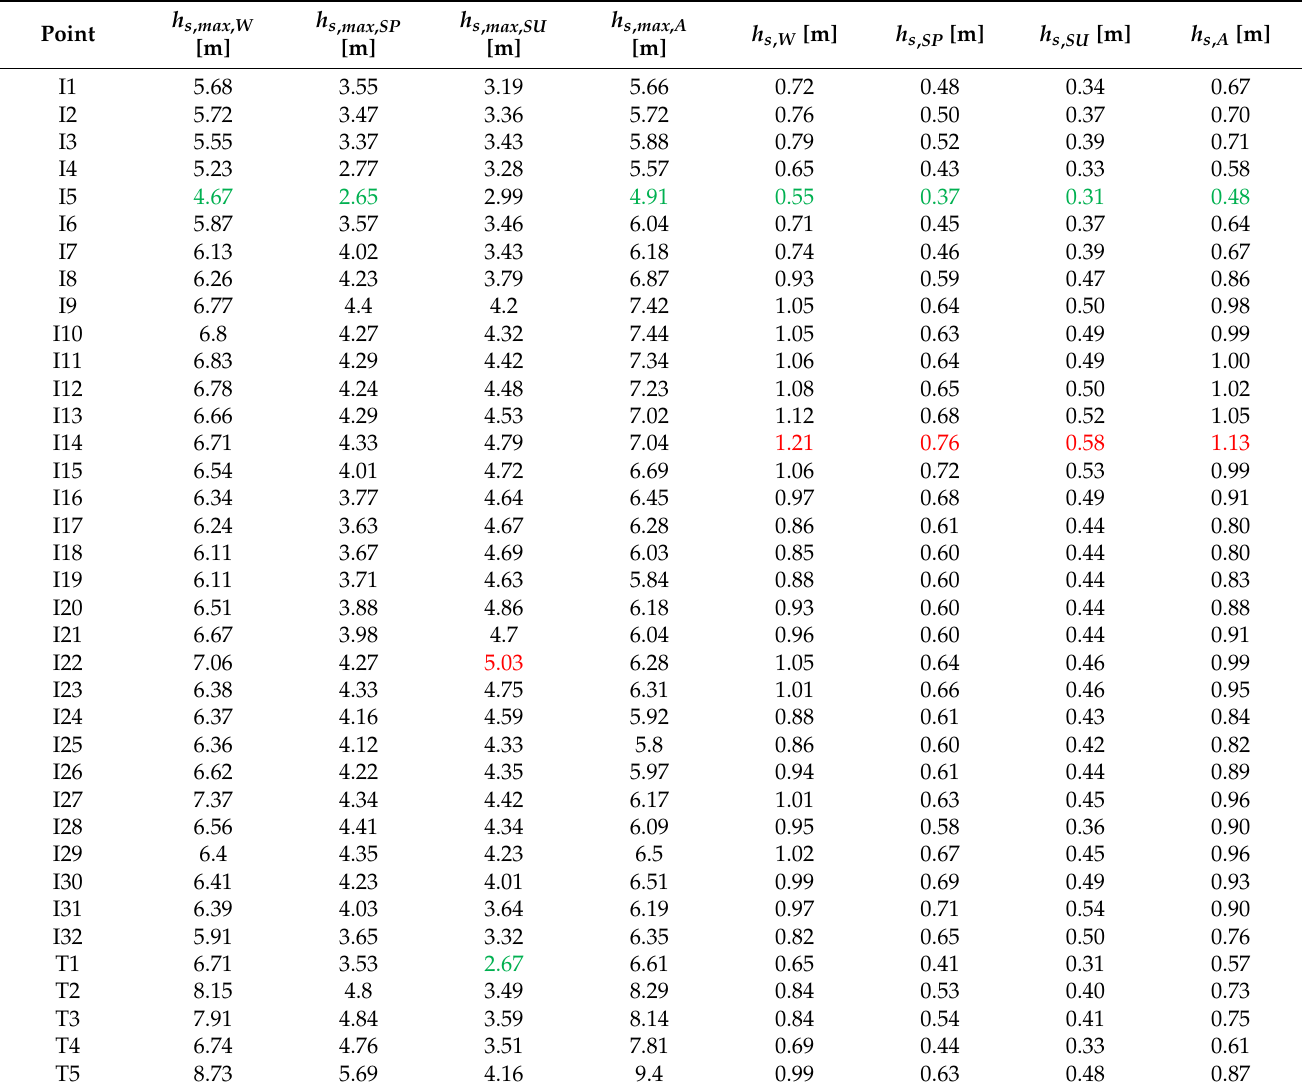
Table 3. Values of seasonal maximum significant wave height h s , max , i and of seasonal average signifi- cant wave height h s , i , where the i-th season has been indicated with subscripts W for winter, SP for spring, SU for summer and A for autumn. Legend: the higher values are in red, and the lower values are in